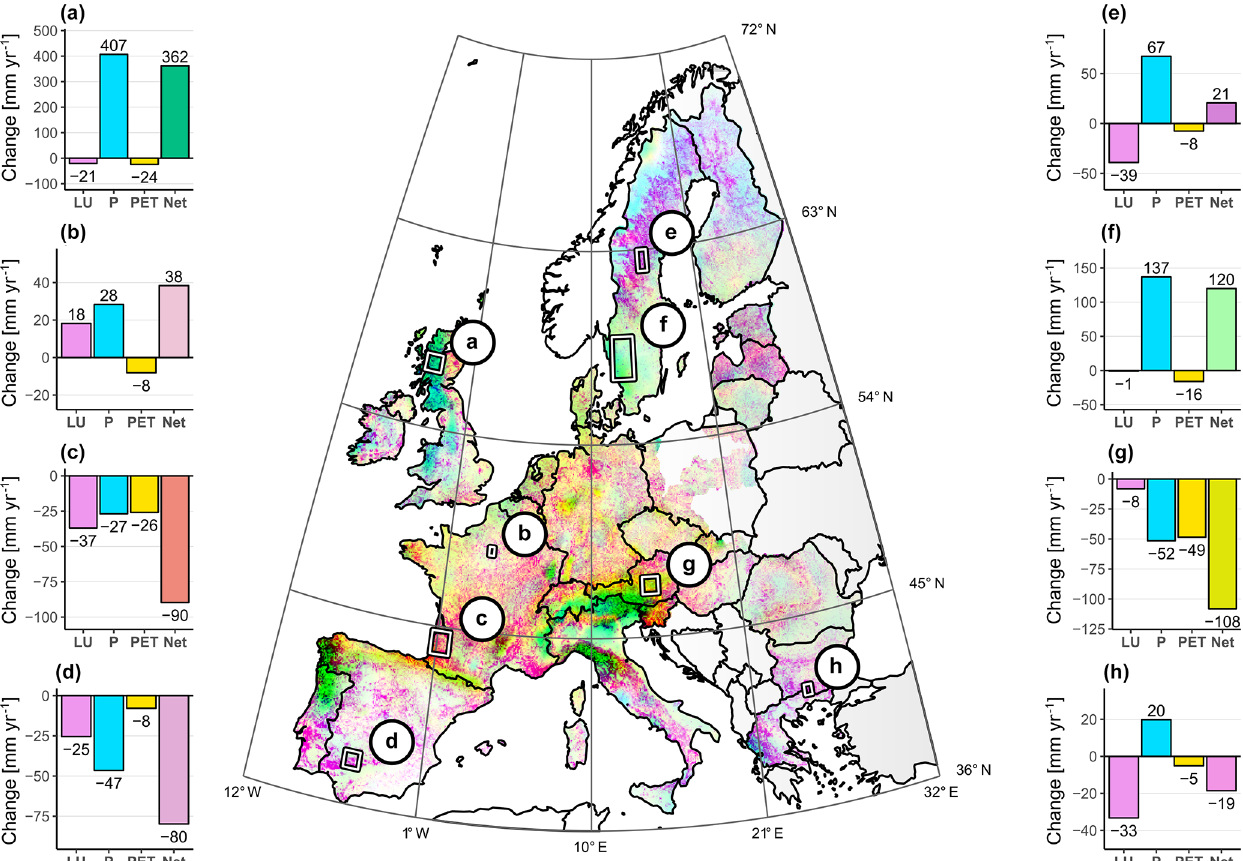
Figure 9. Distribution of the absolute contribution of climate ( P and PET) and land use (LU) changes to changes in streamflow over the period 1960–2010. See the caption of Fig. 8 for an explanation of the colours. The side panels show the absolute contributions of LU, P, and PET and the net change for the selected regions. (a) Southern Highlands (Scotland), (b) Paris metropolitan area (France), (c) Landes forest region (France), (d) Seville region (Spain), (e) central Sweden, (f) southern Sweden, (g) Styria region (Austria), and (h) Smolyan Province (Bulgaria). Domain averages are listed in Table